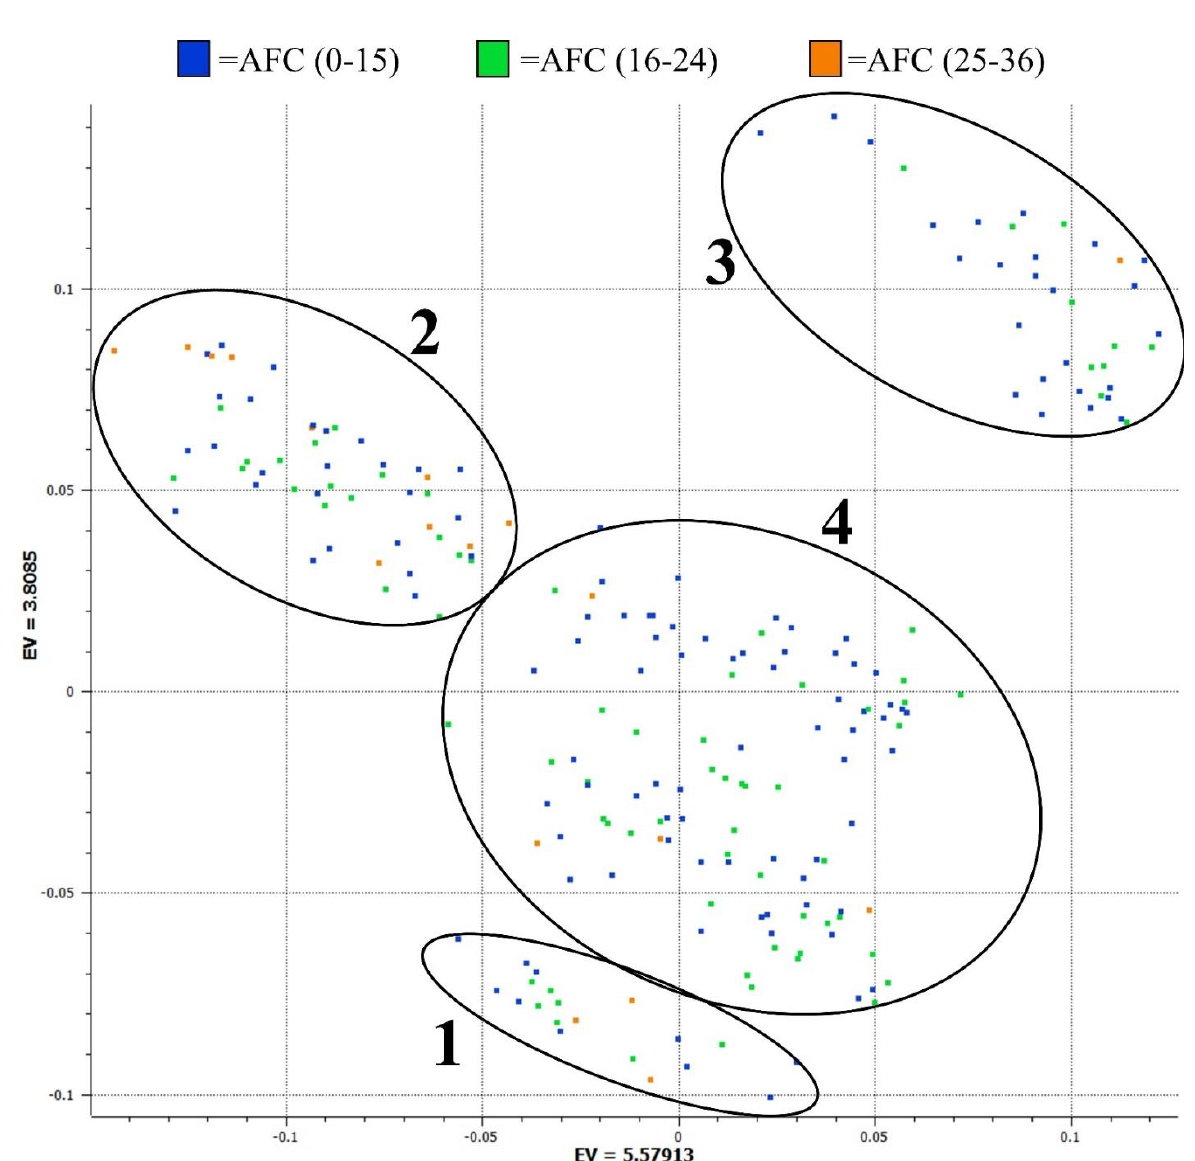
Figure 1. Principal component analysis plot to group animals by genotype by plotting the two largest eigenvectors (EV). Group 1 are heifers of a single SimAngus sire; Group 2 are all Hereford-sired heifers; Group 3 are heifers of a single Angus sire; and Group 4 are the heifers of the remining Angus, Simmental, SimAngus and Shorthorn sires. The individual heifers are color coded based on the number of the antral follicle count (AFC) observed, with blue exhibiting lower (0–15), green medium (16–24) and orange the highest number of (25–36) the AFC observed.